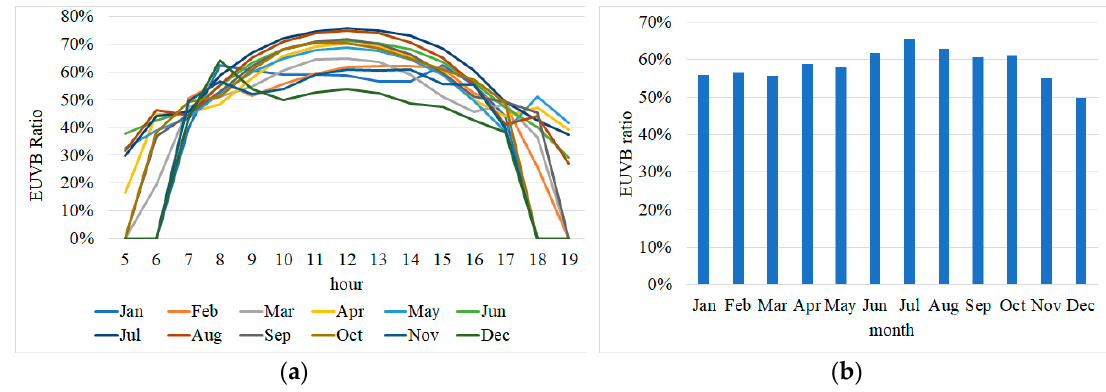
Figure 2. Monthly/hourly erythemally weighted UVB (EUVB) ratio index graph ( a ) and the average ( b